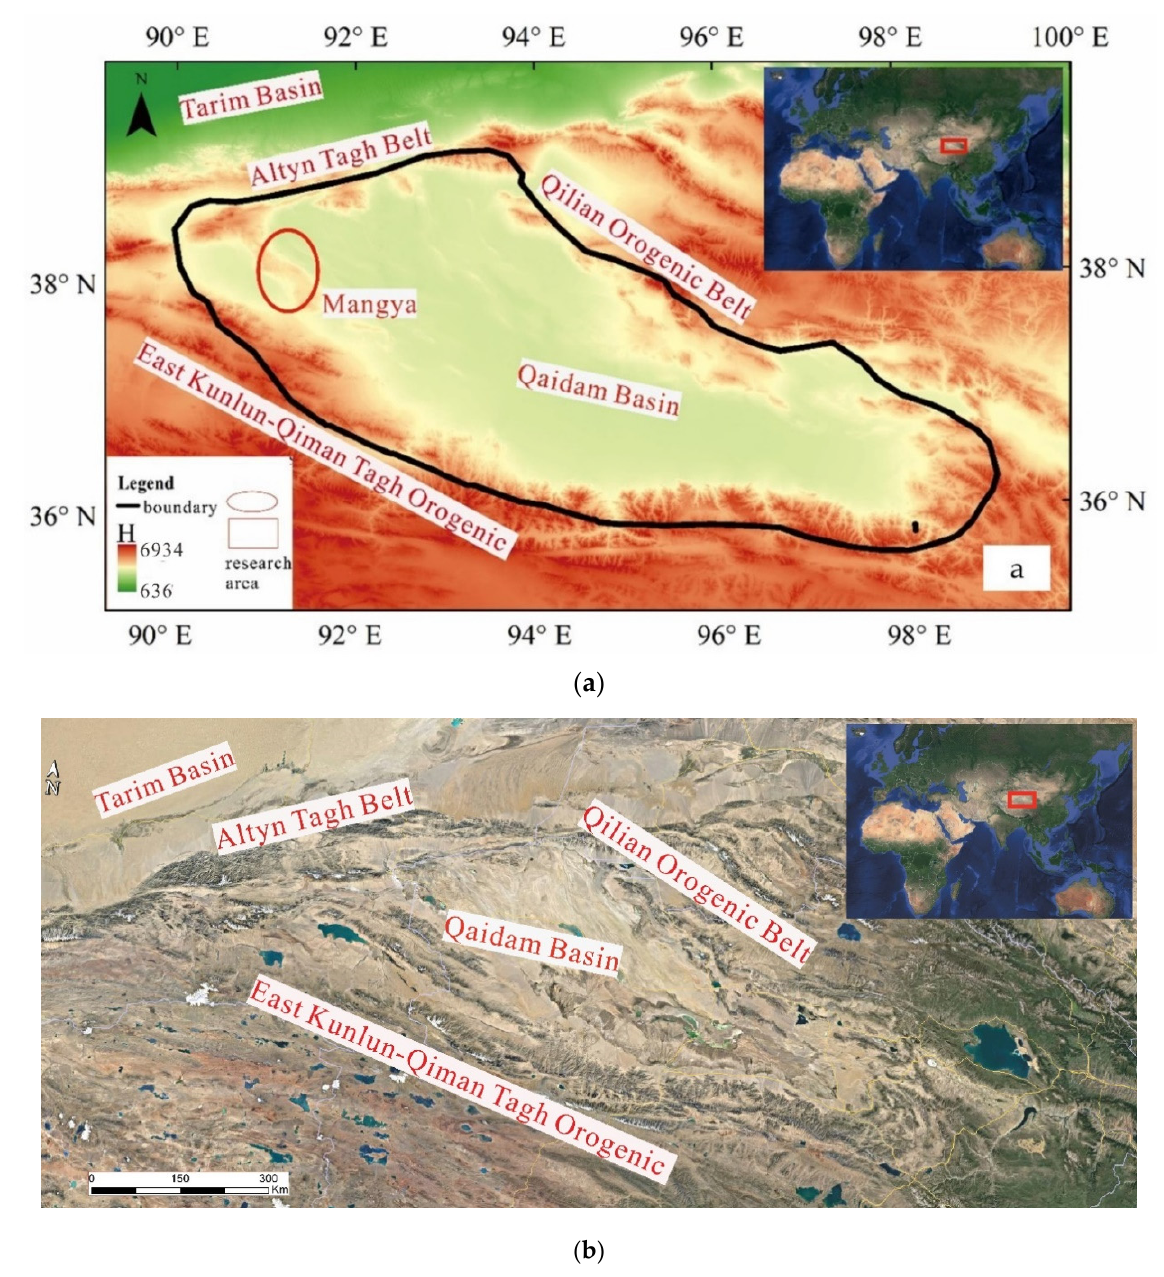
Figure 1. The elevation ( a ) and visible light image ( b ) of the Qaidam Basin. The red circle in ( a ) indicates the research area. The elevation data ( a ) are generated from the Advanced Spaceborne Thermal Emission and Reflection Radiometer Global Digital Elevation Model. Remote sensing image credit: Google Earth.